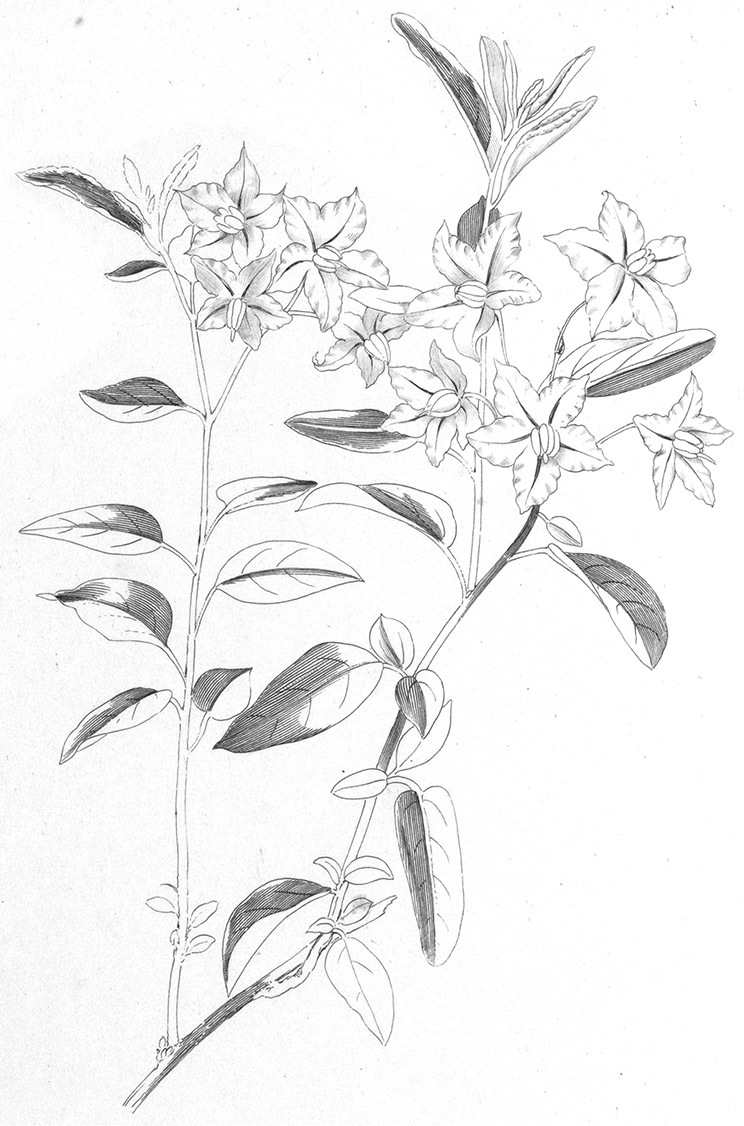
Lectotype of Solanum ligustrum Lodd. (Loddiges 1833: tab. 1963). Reproduced with permission of the Natural History Museum Botany Library.